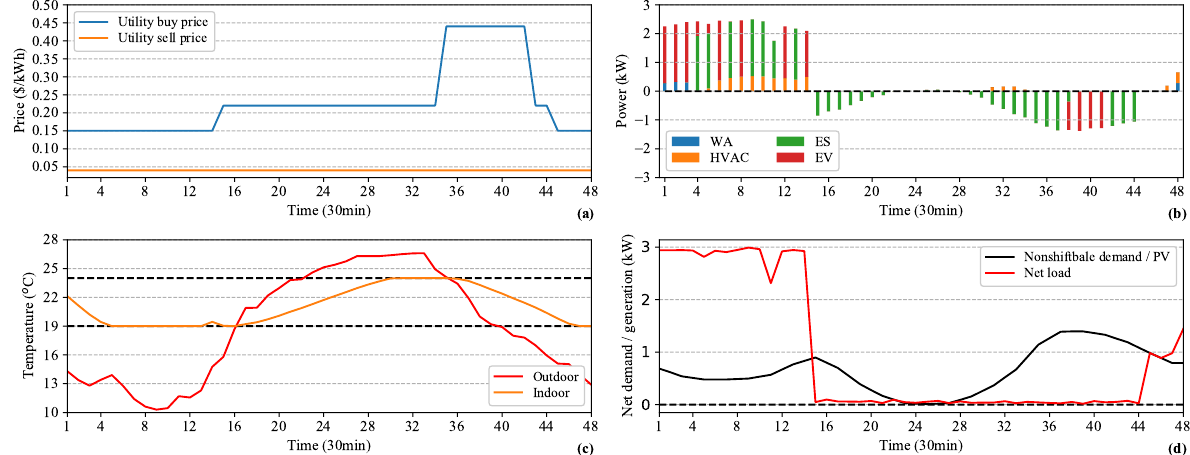
Figure 7. ( a ) Utility buy and sell prices, ( b ) aggregated schedule of flexible DERs, ( c ) indoor and outdoor temperature, and ( d ) net demand/generation of the household with/without flexible DERs for the investigated winter day under the TD3